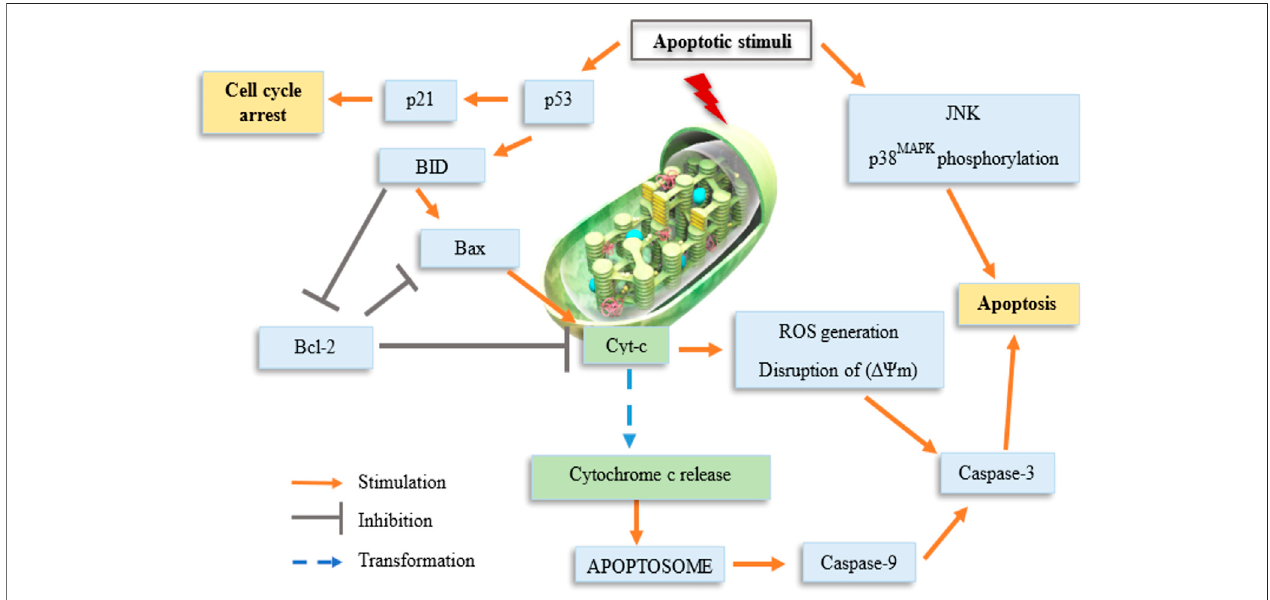
FIGURE 1 | Schematic representation of organotin(IV) compounds-induced cell cycle arrest.